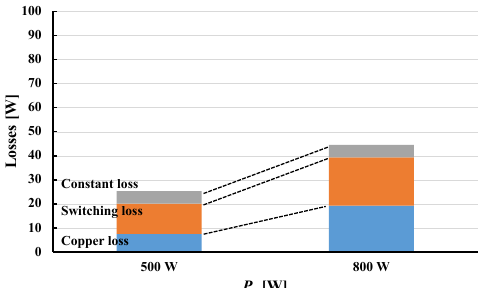
Figure 23. Loss comparison of series circuit when output voltage is 280